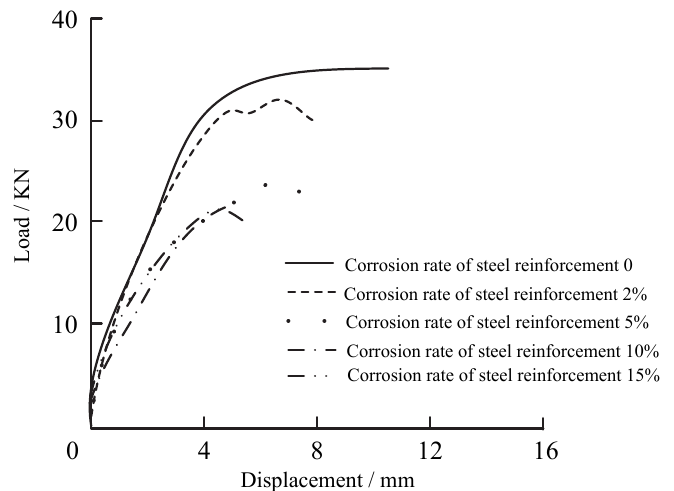
Figure 10: Curves of load-displacement (axial compression ratio